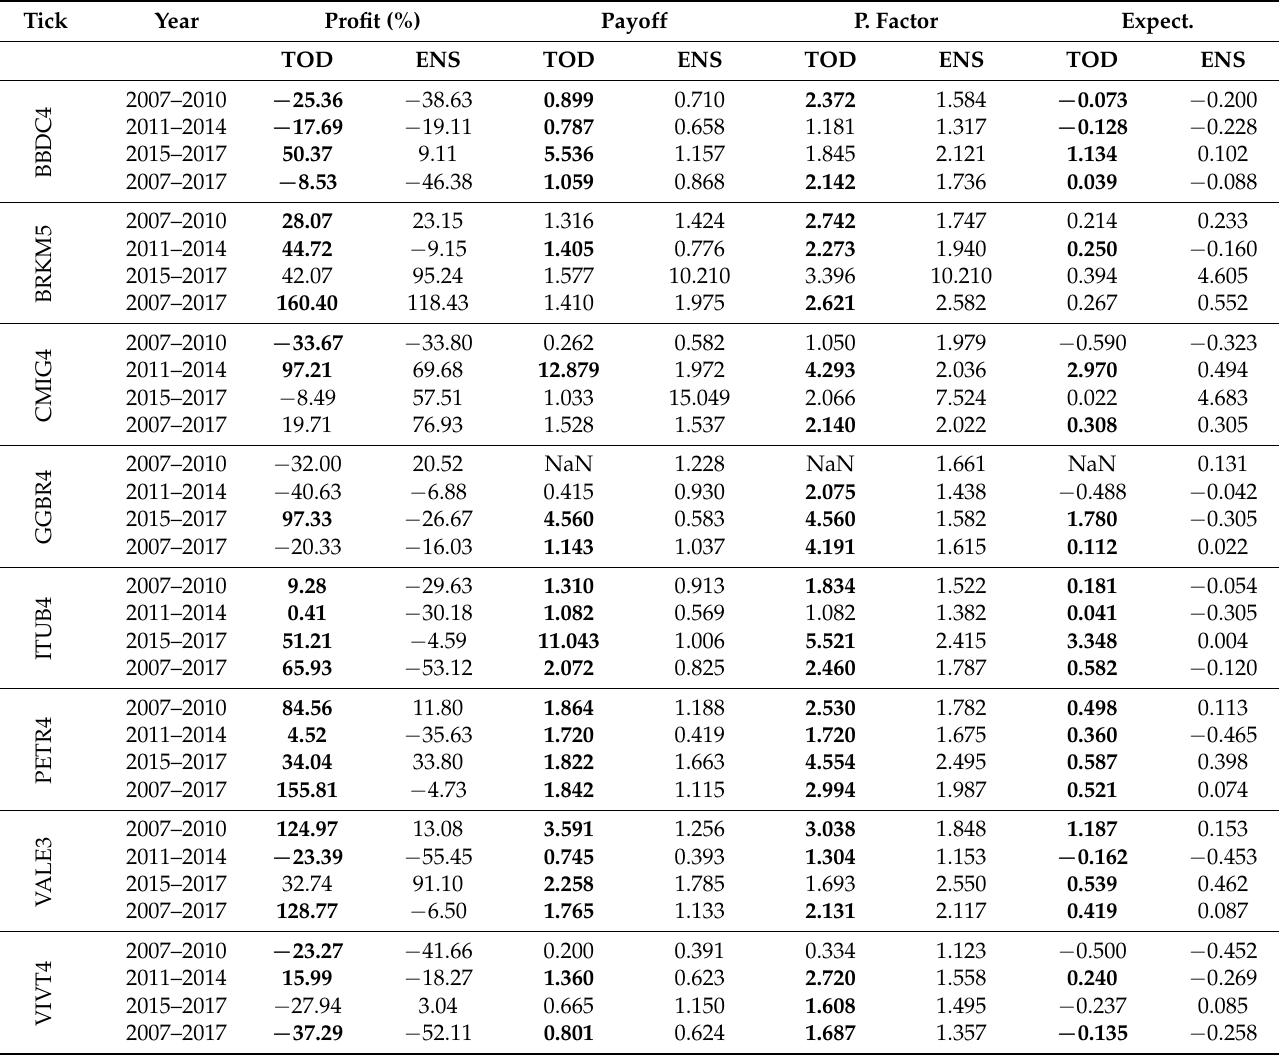
Table 4. Performance metrics: profit-based. (By the authors.) The results in which the performance of the TOD model is superior to that of the ENS are